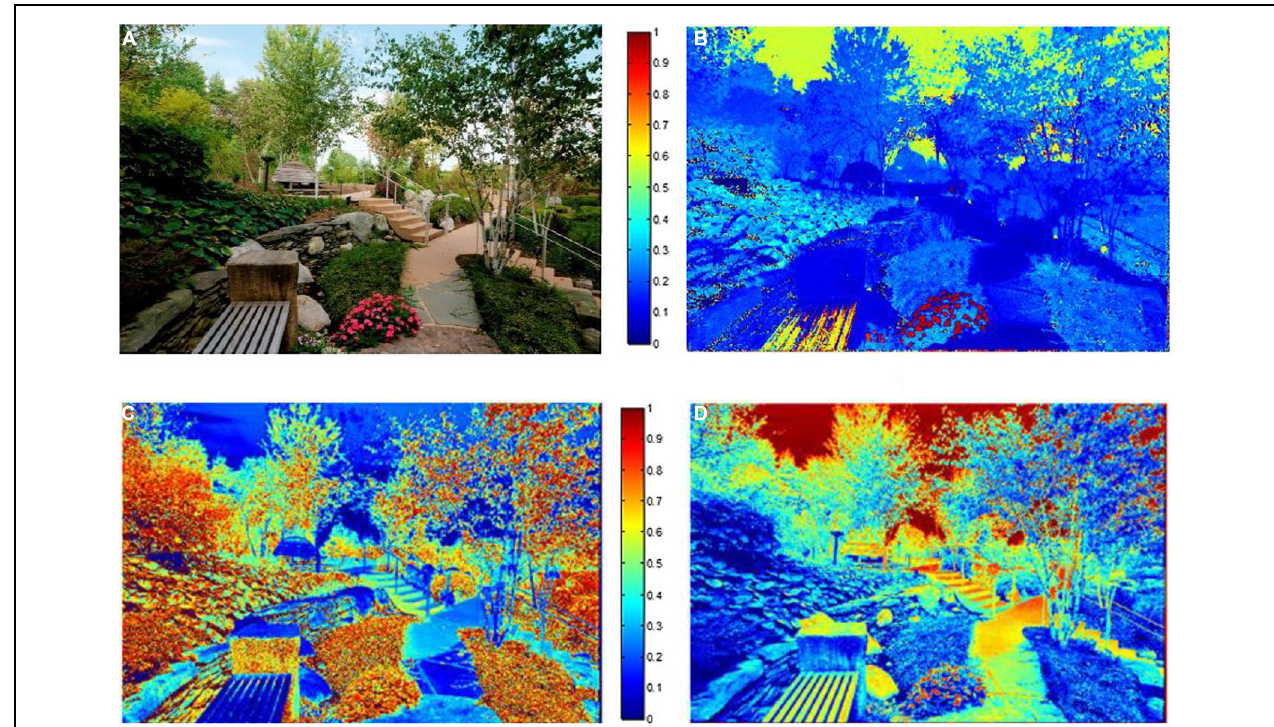
FIGURE 1 | (A) A sample image (B) Image’s hue map (C) Image’s saturation map (D) Image’s brightness map. Pixels with hot colors have higher hue, saturation, and brightness in figures B , C , and D ,